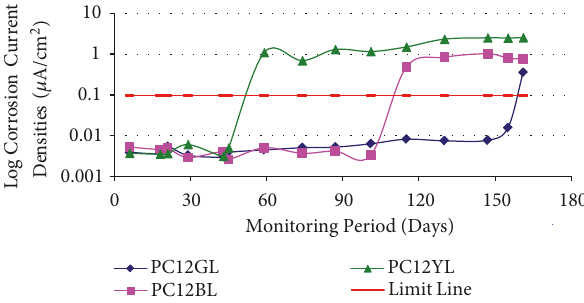
Figure 10: Log corrosion current densities versus time for PCDC at w/c 0.73.